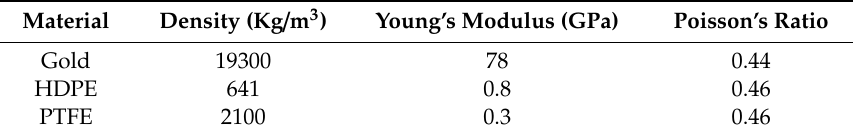
Table 1. Simulation parameters of the materials of the proposed